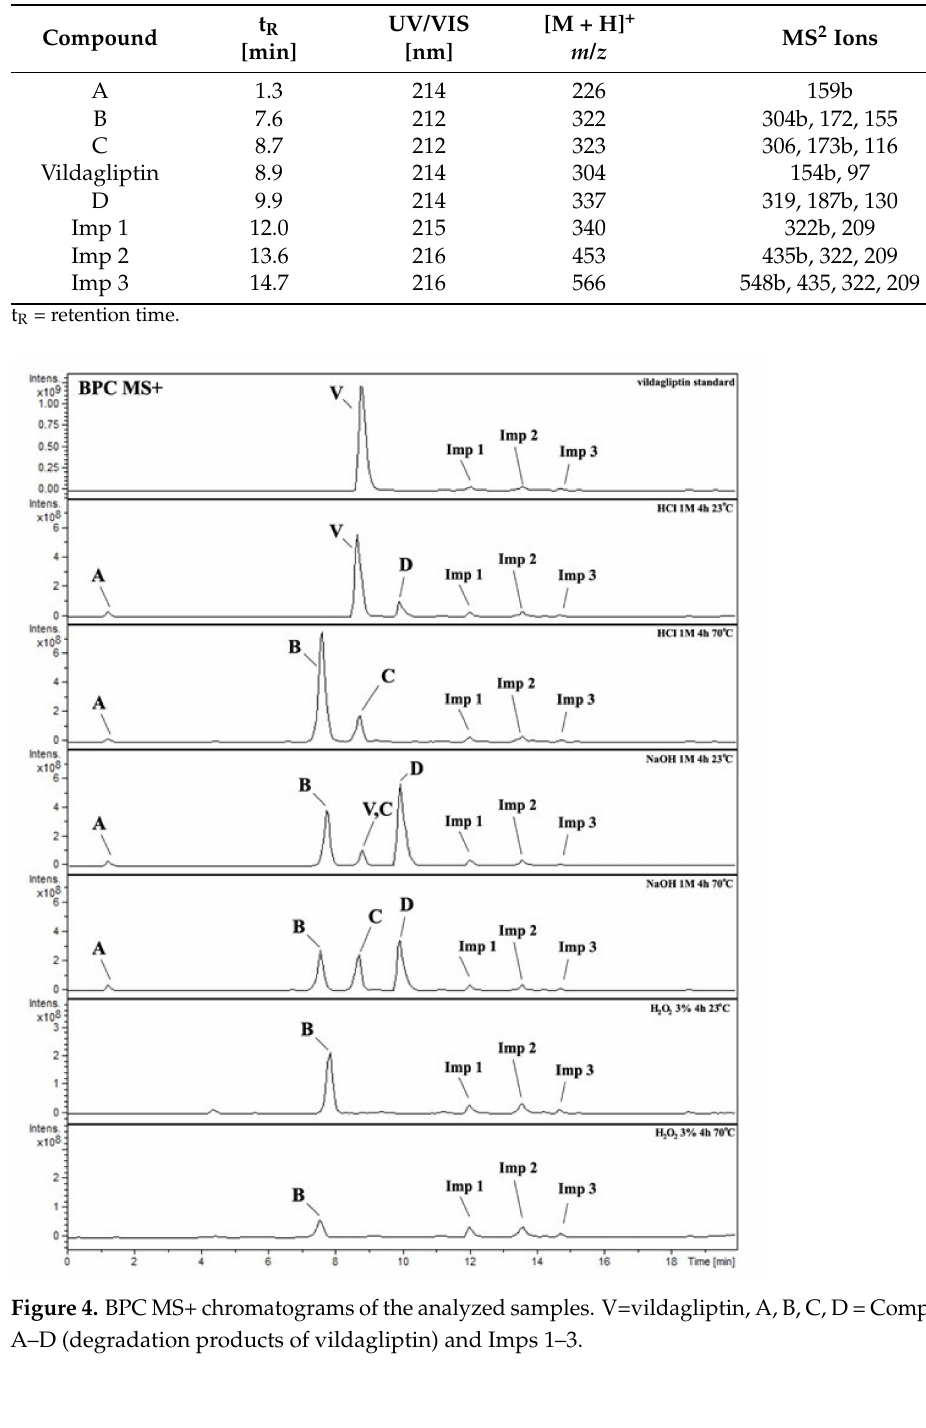
Table 5. UHPLC-DAD-MS2 data of the detected compounds in the analyzed samples.